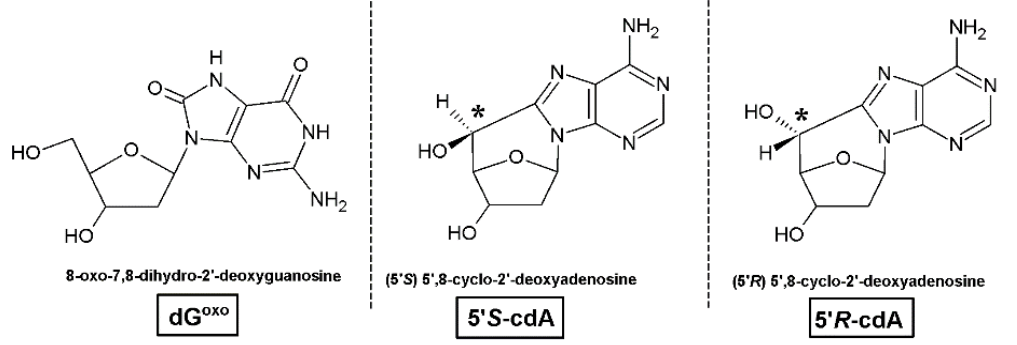
Figure 1. Graphical representation of the structure of the discussed DNA damage.